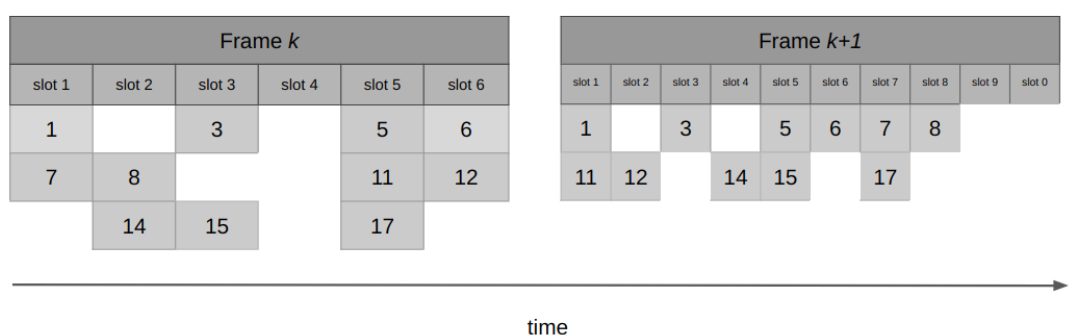
Figure 10. Fixed competitive TDMA (FC-TDMA) operation. In the first frame, packets collide in every slot. For the following frame, the number of slots is increased, resulting in five successful transmissions out of ten slots. The number in each packet represents the node’s